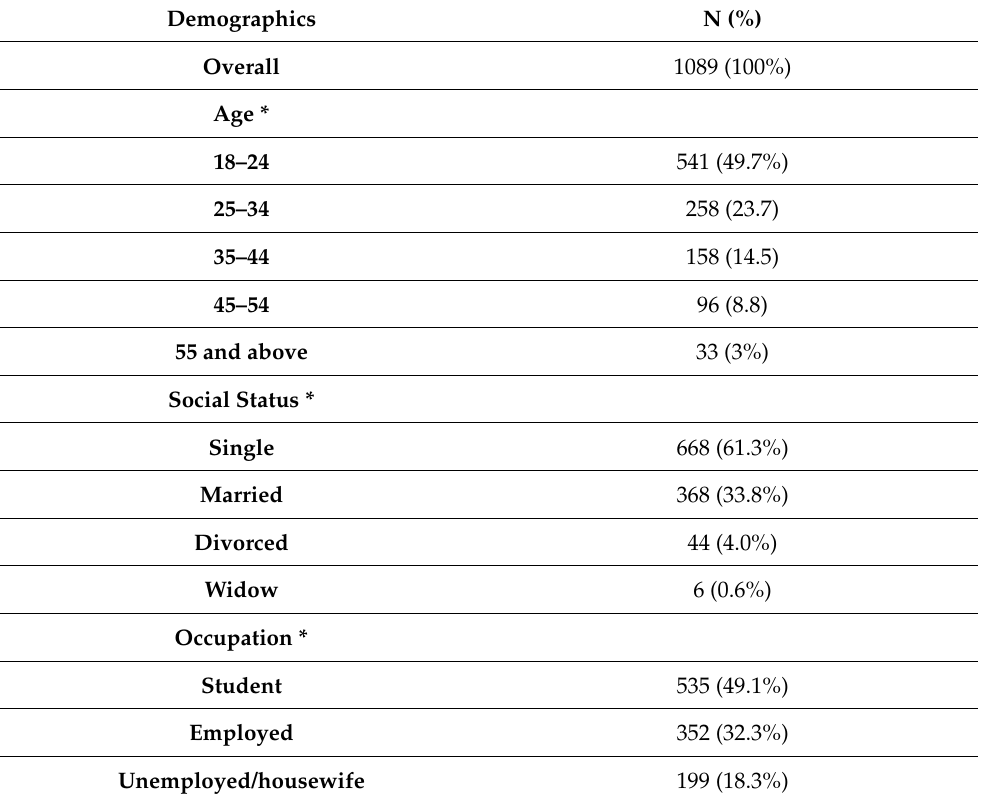
Table 1. Descriptive statistics and participants’ socio-demographic